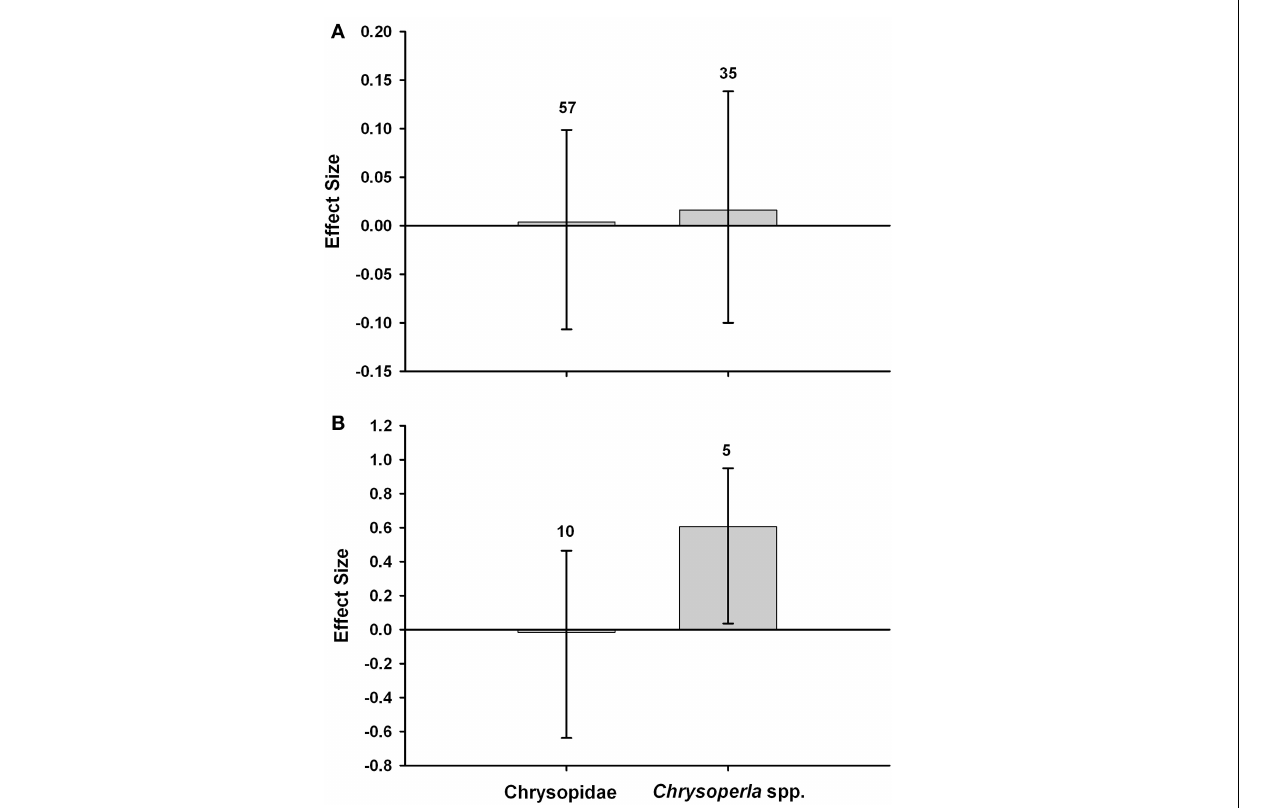
FIGURE 3 | Meta-analyses of field studies examining the abundance of lacewings in Bt maize, and non-Bt maize that was untreated with insecticide (A) or treated with insecticides (B).